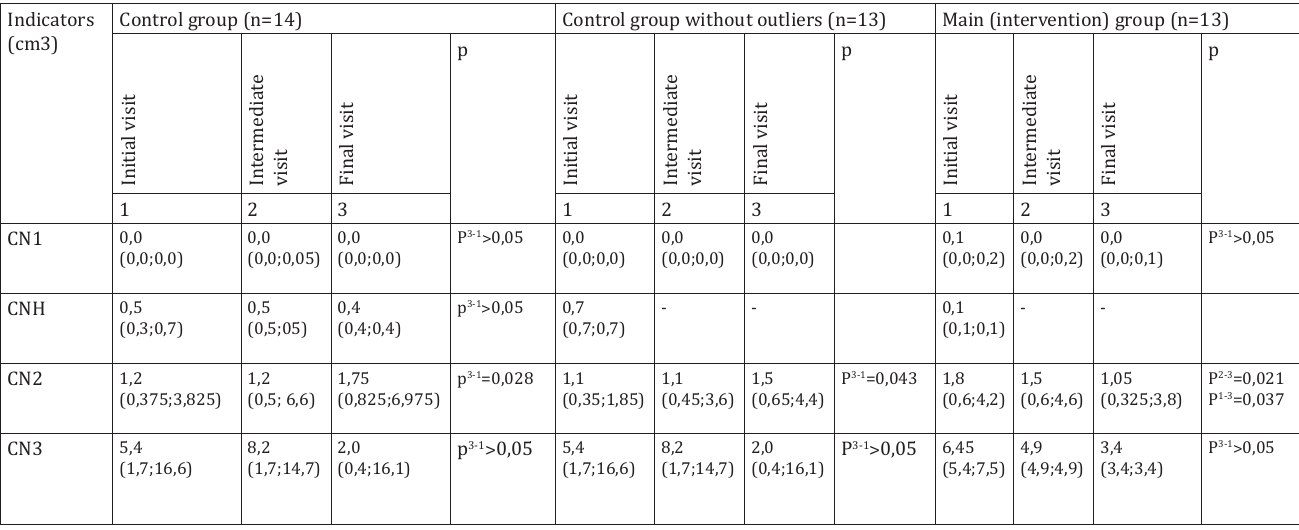
Dynamics of changes in the volumes of various types of thyroid nodules at different periods of the study